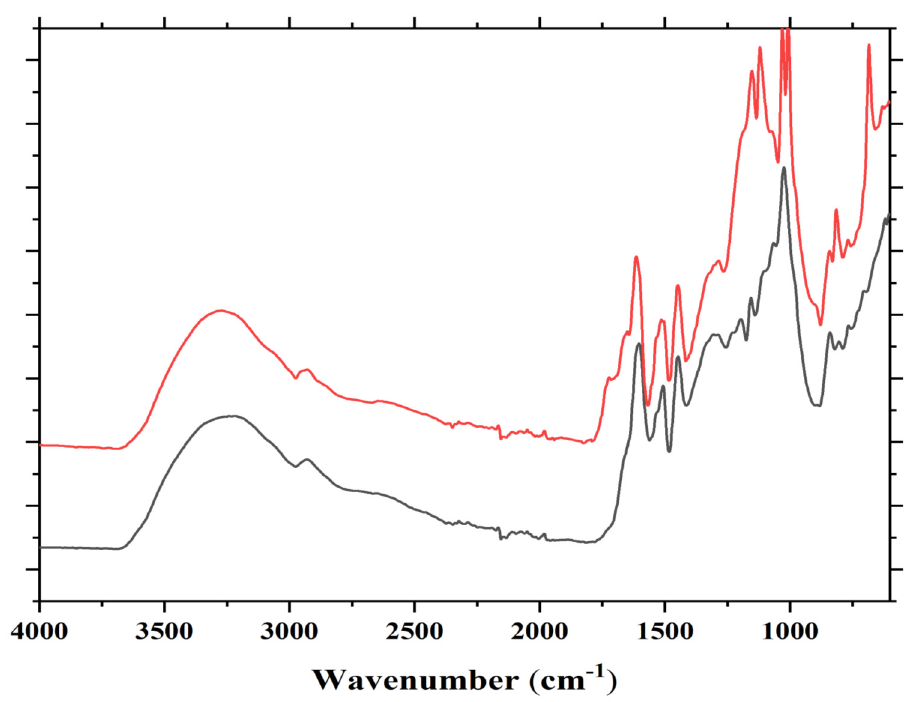
Figure 2. FTIR of reaction product mixture of condensed tannin with ISP at 80 ◦ C without catalyst (lower spectrum) and with catalyst (higher spectrum) both at 80 ◦ C.